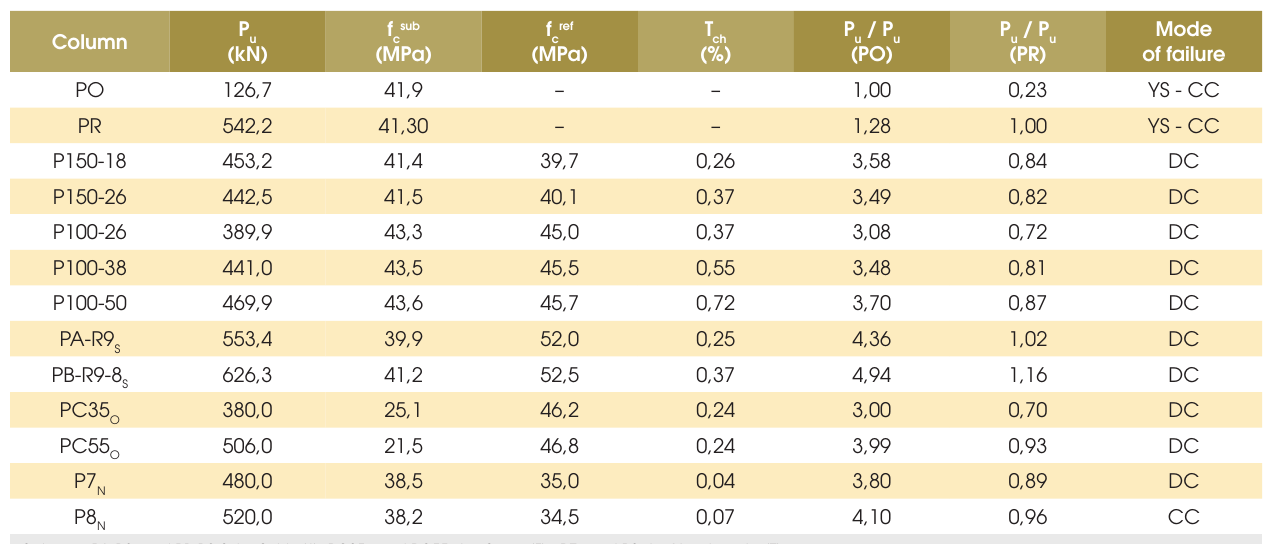
Table 1 – Ultimate loads, modes of failures, concrete compressive strengths, connector ratio t and ratios between ultimate